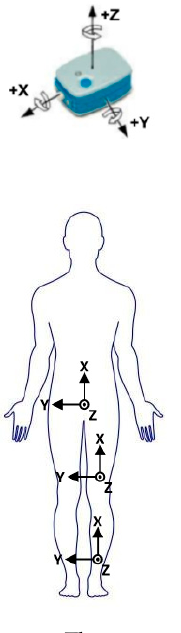
Figure 1. The segment reference frames and sensor reference frames.